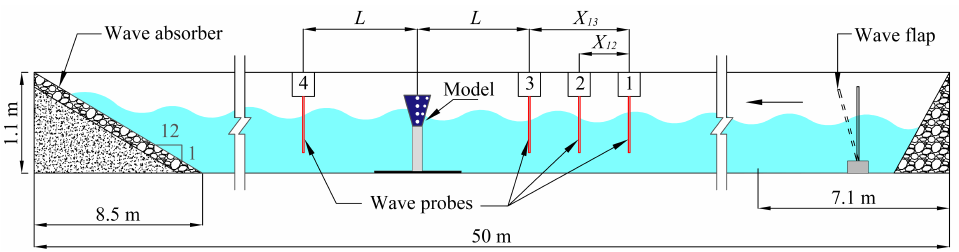
Figure 2. Typical view of the physical wave tank.